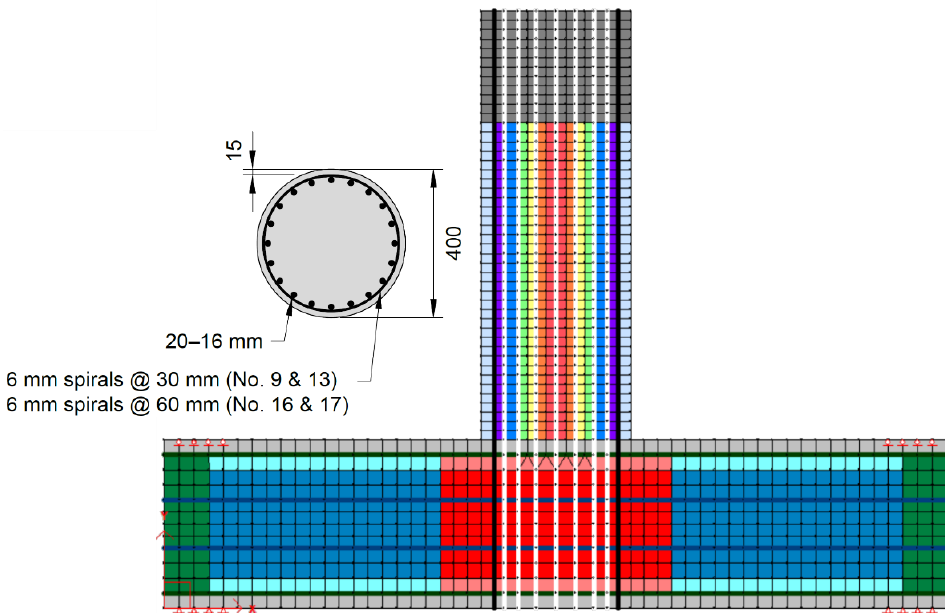
Figure 6. Example of finite element model and typical cross-section of columns tested by Ang et al. [6,7].